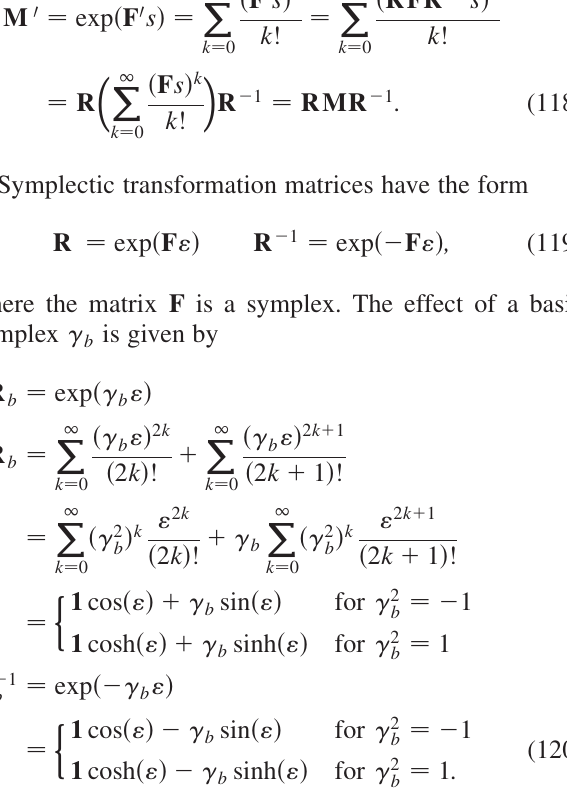
TABLE II. Table of symplectic transformations in two dimensions. a indicates the rows and b the column: (cid:1) 0